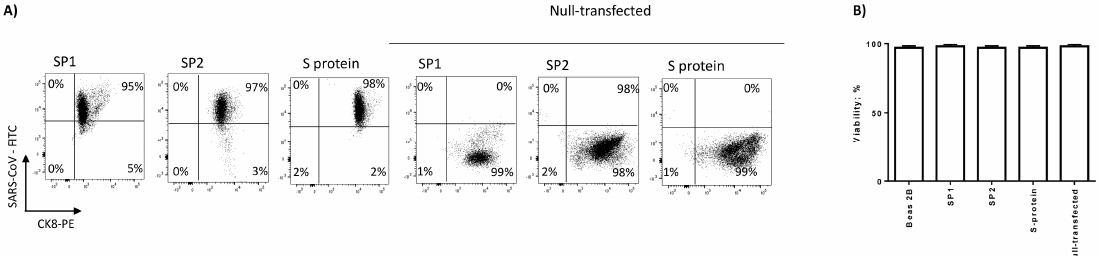
Figure 2. ( A ) Representative intracellular expression of SP1, SP2, and S proteins and surface expression of the epithelial marker CK8-PE in Beas-2B cells after transfection. ( B ) Beas-2B viability, assessed by the LDH assay, in basal and transfected conditions. The transfection with 0.5 µ g of control fluorescent antibody was used as a positive control (null-transfected). The values are presented as mean ± standard